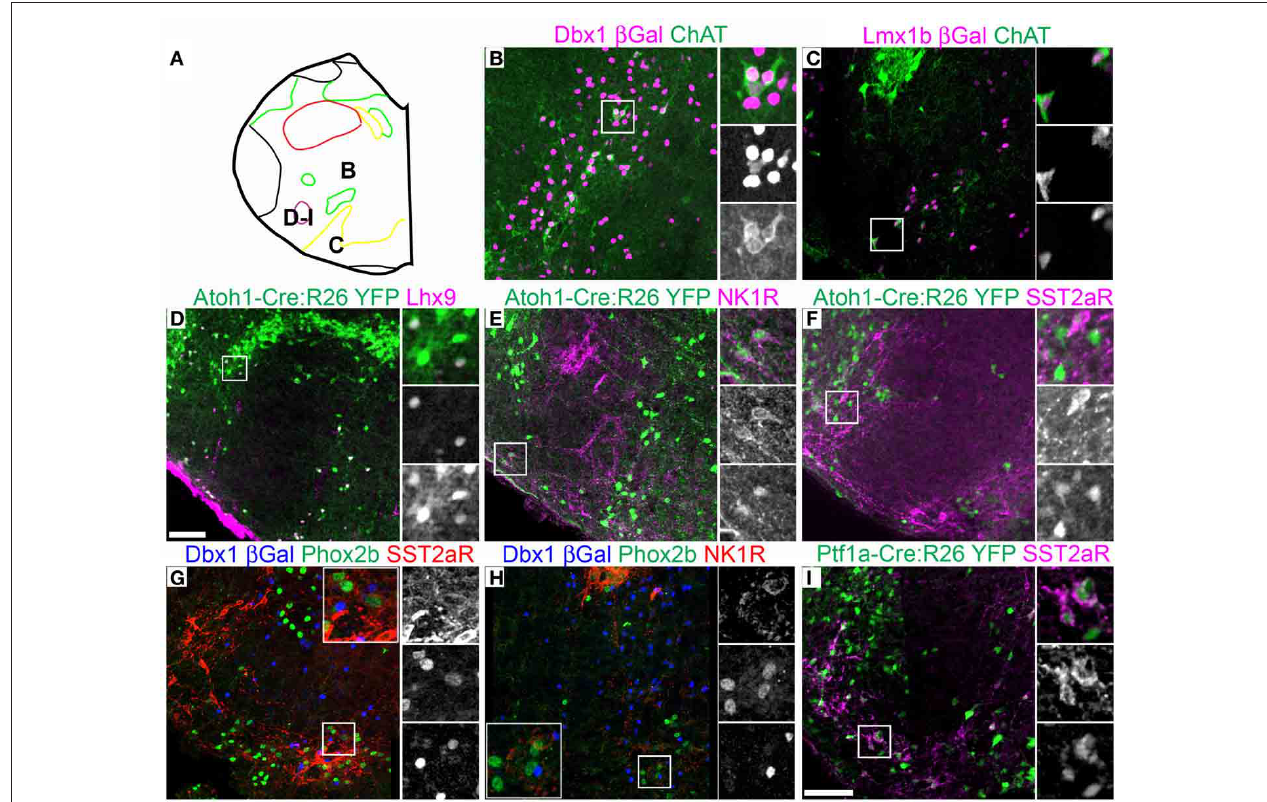
β -gal ( B,C , magenta, G,H , blue), or YFP ( D–F , green) with ChAT ( B,C , green), Lhx9 ( D , magenta), NK1R ( E , magenta, H , red), SST2aR ( F,I, magenta, G , red), and Phox2b ( G,H , green). Boxed regions in (B–F,I) are expanded to right showing overlapping (right, top), and single colors magenta (middle), and green (bottom). Boxed regions in (G,H) are expanded (inset) with single colors red (right, top), green (middle), and blue (bottom). Scale bar = 500 μ